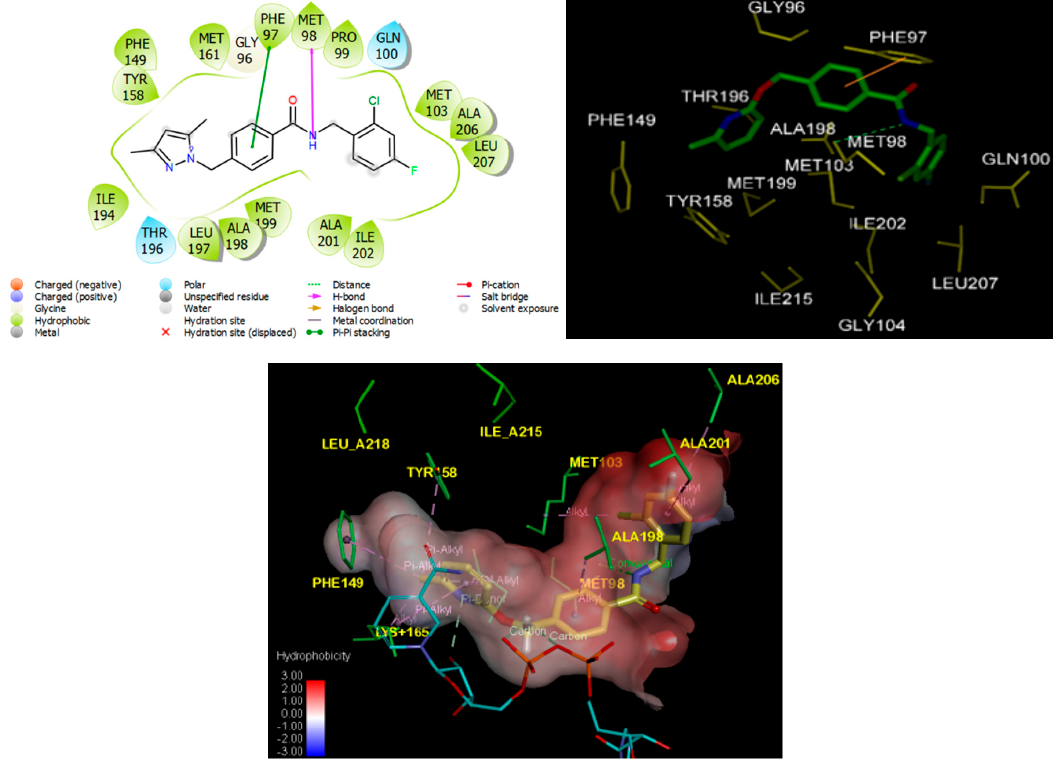
Figure 3. (Left) 2D schematic interaction diagram of the most potent inhibitor BHMB1 [23] at the active site of InhA of Mt . (Right) 3D structure of the InhA active site with bound inhibitor BHMB1. (Bottom) Hydrophobic surface of the active site of InhA showing conventional hydrogen bonds (green) and alkyl group hydrophobic contacts (pink). Surface coloring legend: red = hydrophobic, blue = hydrophilic and white = intermediate.